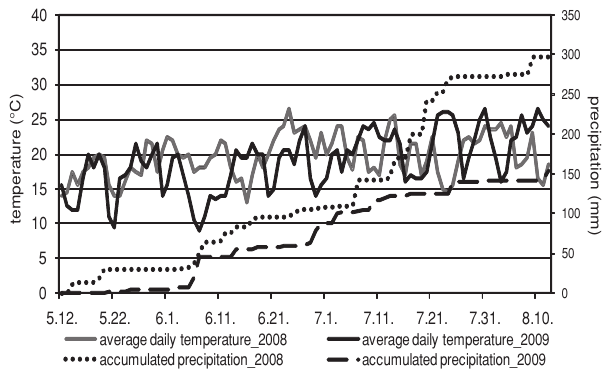
Figure1: Meteorological data during tomato vegetation period in 2008 and 2009.